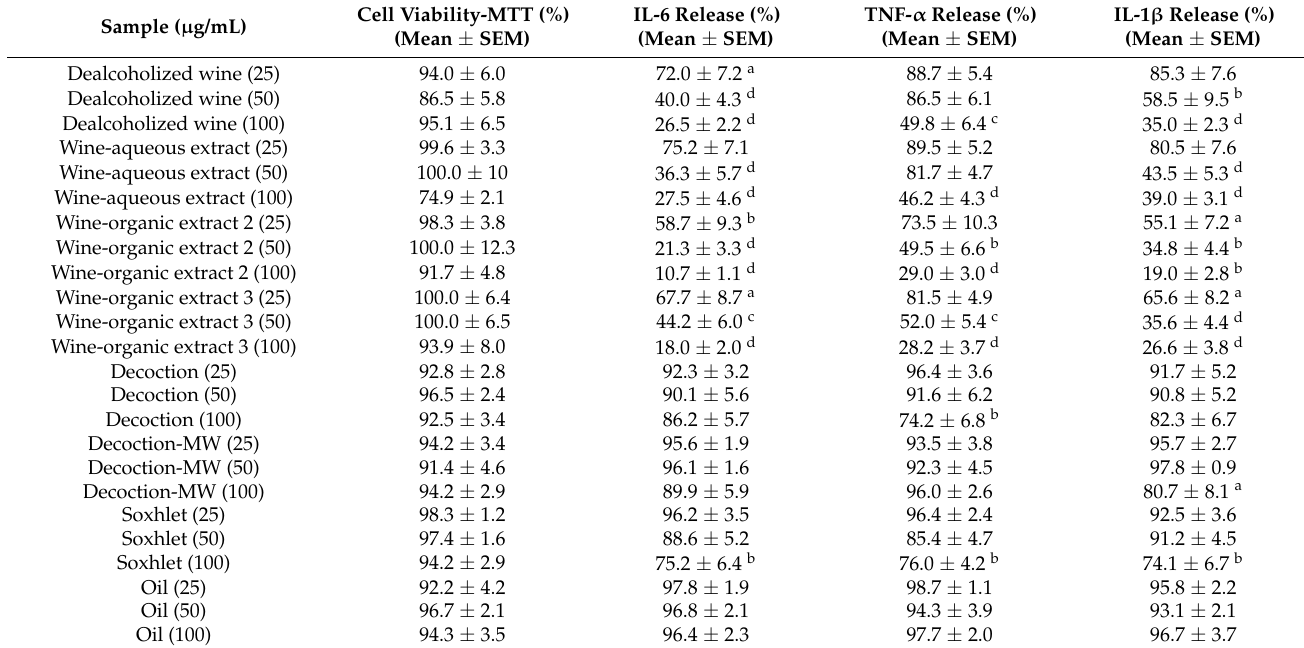
Table 8. Effects induced by extracts on cell viability and LPS-induced cytokine release (IL-6, TNF- α , and IL-1 β ) in macrophages. Macrophages were exposed for 24 h to 25, 50, and 100 µ g/mL of extracts. Sample ( µ g/mL)